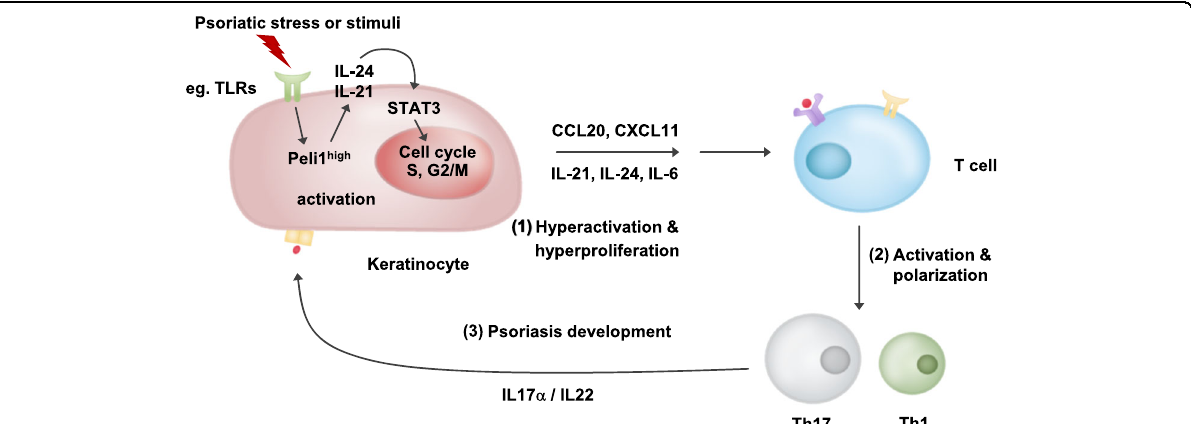
Fig. 6 Model of Peli1-mediated cell cycle activation, which generates a feedback cross-link between keratinocytes and the T cell response in the psoriatic microenvironment. A detailed discussion of this model is provided in the